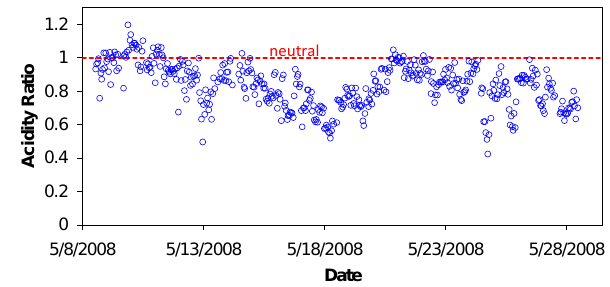
Fig. 4. Volume growth factor versus relative humidity for DAASS measurements with one hour averaging during FAME-08.